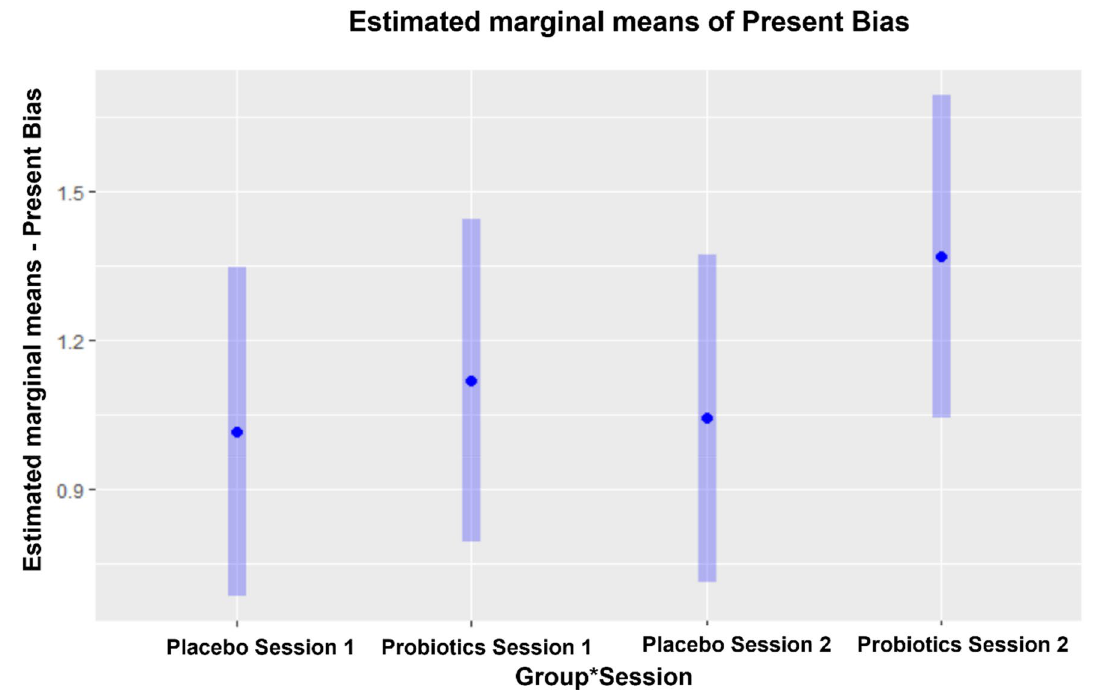
Figure 5. Estimated marginal means of Present Bias (n = 57). Estimated marginal means of present bias calculated using a linear mixed model considering as factors Time (Session 1 and Session 2) and Protocol (Probiotics and Placebo) and its interaction (Time*Protocol). Trial and Time are taken as repeated measures and participant-specific and trial effects are used as the random effects. Participants’ present bias (Beta) was estimated based on the model of convex budgets by Andreoni and Sprenger 35 considering their responses during the MCG, with are averaged for each session. Dots represent participants’ estimated marginal means for each session and treatment. Bars indicate the 95% confidence interval of the linear model employed for data analyses. Values above 1 are interpreted as indicating future